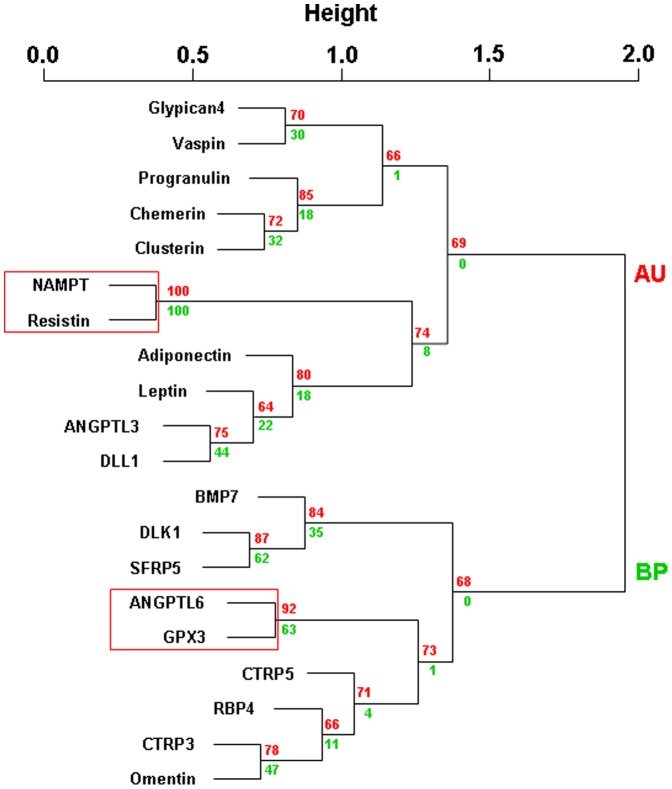
Hierarchical clustering of 20 serum adipokine concentrations in obese patients (n = 141).We provide approximately unbiased (AU, numbers in red) p-values and bootstrap probability (numbers in green) values as measures of certainty for clusters. Values are based on 10,000 bootstrapping replicates. AU≥90% was considered as strong evidence for the cluster and is marked by red rectangles (only largest possible clusters are marked). Abbreviations: CRP, high sensitive C-reactive protein; ANGPTL 3, angiopoietin-like protein 3; ANGPTL 6, angiopoietin-like protein 6; BMP7, bone morphogenetic protein 7; CTRP3, complement C1q tumor necrosis factor-related protein 3; CTRP5, complement C1q tumor necrosis factor-related protein 5; LPS, Lipopolysacharid (Endotoxin); GPX3, glutathione peroxidase 3; DLL1, delta-like protein 1; DLK1, preadipocyte factor 1; NAMPT, nicotinamide phosphoribosyltransferase (visfatin); RBP4, retinol binding protein 4; SFRP5, secreted frizzled-related protein-5; TG, triglycerides.